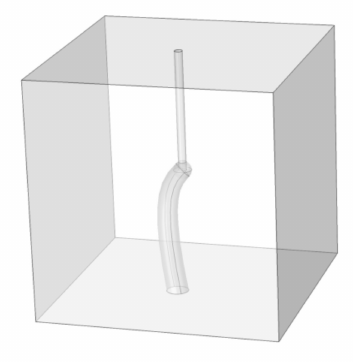
Figure 4. Three-dimensional reconstruction